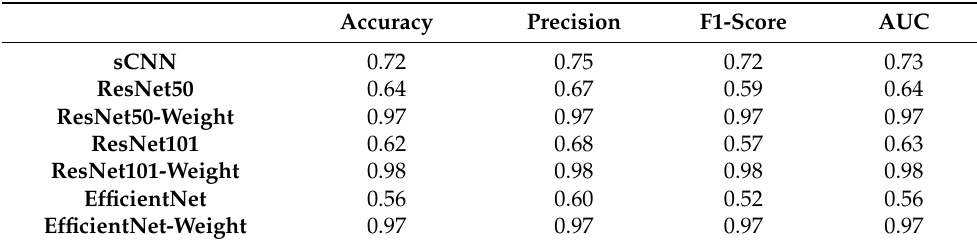
Figure 6. Precision and accuracy of each model on the test dataset. The models without pre-trained weights are labeled as ResN50, ResN101, and EffNet for ResNet50, ResNet101, and EfficientNet-B7. The models using pre-trained weights are labeled as ResN50W, ResN101W, and EffNetW for ResNet50, ResNet101, and EfficientNet-B7. Table 1. Evaluation metrics of each model by using an image-level splitter. Accuracy